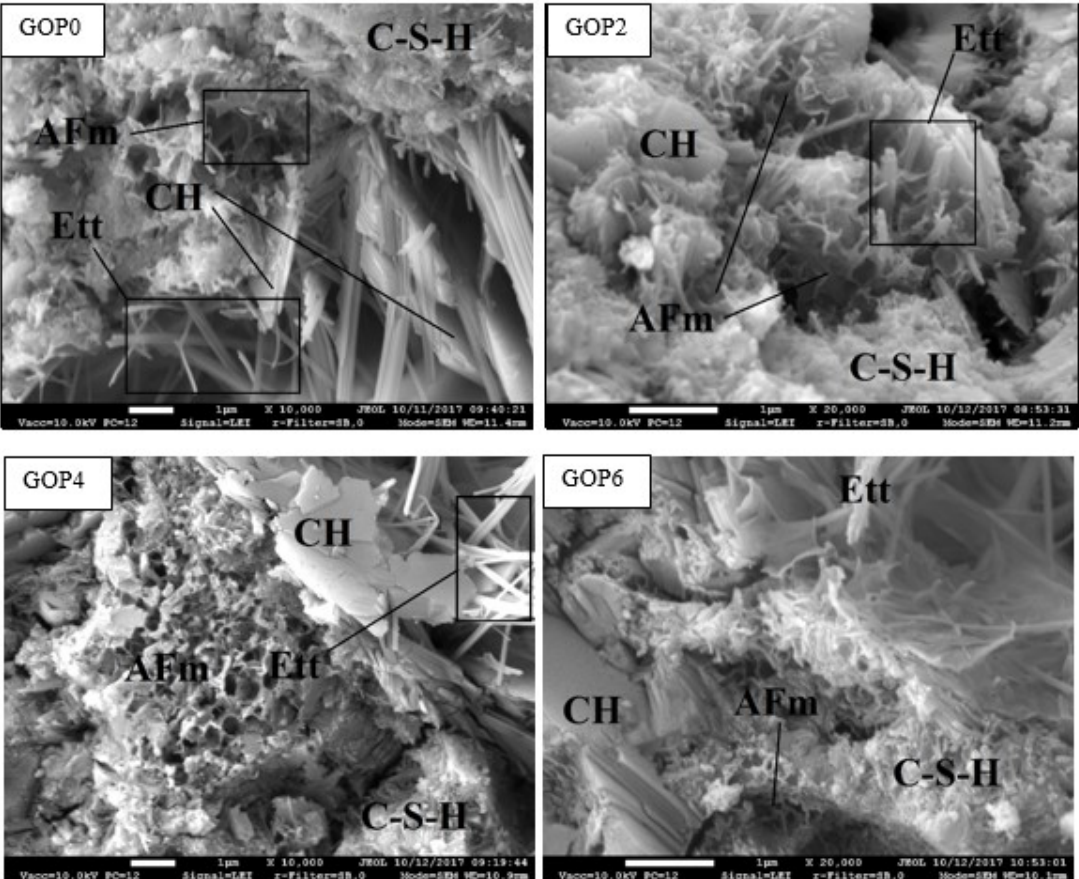
Figure 7. Microstructure of plasticized cement pastes cured for 28 days: AFm—tricalcium aluminate monosulfate hydrate; CH—portlandite (calcium hydroxide); C-S-H—calcium silicate hydrate; Ett—ettringite (calcium trisulfoaliuminate hydrate).